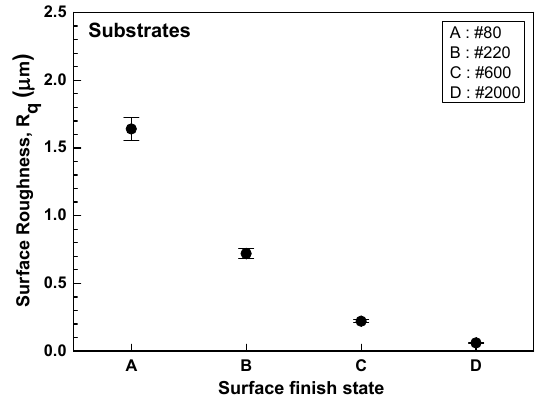
Figure 2. Surface roughness values of carbon steel substrates at different surface finish states.